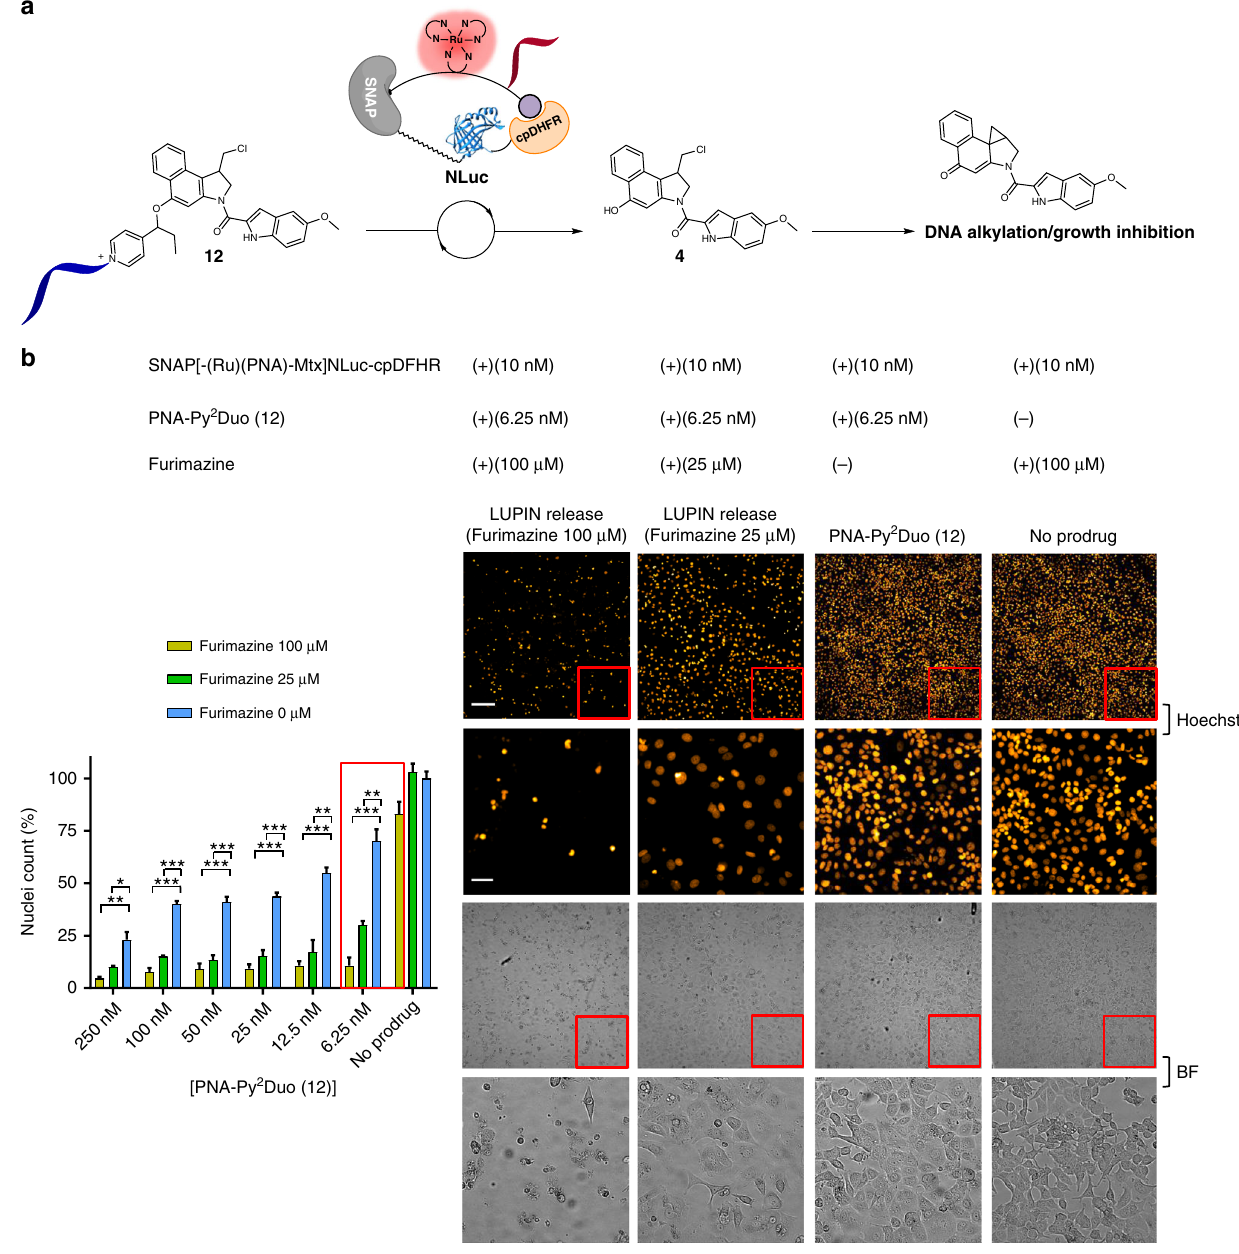
Fig. 5 LUPIN release of cytotoxic duocarmycin analogue in MCF-7 cell culture. a Schematic representation of Duo-OMe ( 4 ) release by LUPIN with furimazine to generate DNA alkylating agent. b Quanti fi cation of cellular growth (MCF-7) by nuclei count. Bar graph of nuclei count across different furimazine and prodrug (PNA-Py 2 Duo 12 ) concentrations (left panel). Representative images of cells (right panel) across different prodrug ( 12 ) and furimazine concentrations imaged by fl uorescence (Hoechst) and bright fi eld (BF). The red square indicates the zoomed-in area below it. The bar graph is the average of three independent experiments ran in triplicates. Error bars show ±1 standard deviation from the mean. Statistics were calculated using a two-tailed t -test with unequal variances (Welch ’ s unpaired t -test). * p < 0.05, ** p < 0.01, *** p < 0.001. Scale bar: 200 µ M; zoom-in scale bar: 50 µ